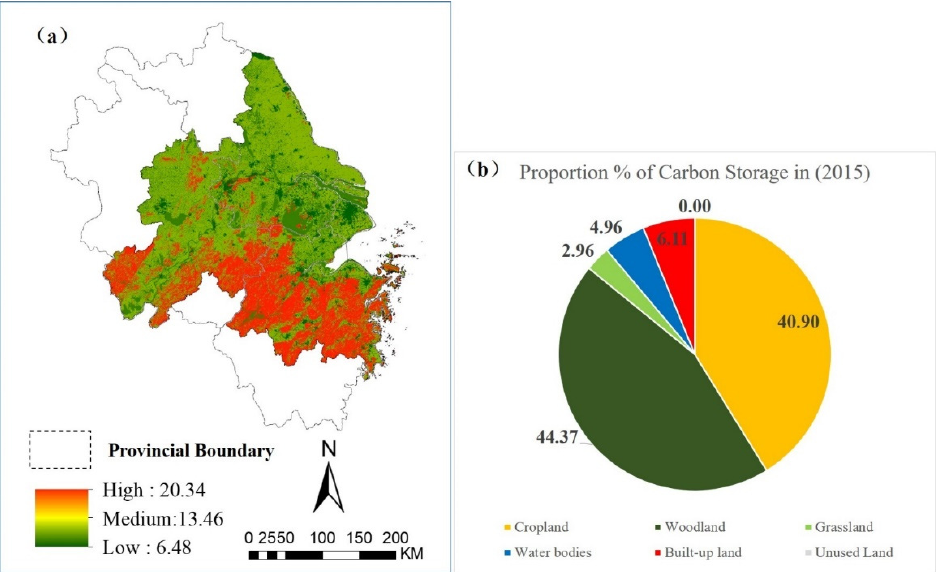
Figure 2. Spatial pattern and proportion % of carbon storage of Yangtze River Delta Region (2015). ( a ) Spatial pattern of carbon storage of Yangtze River Delta Region (2015); ( b ) proportion of carbon storage in LULC of Yangtze River Delta Region (2015).